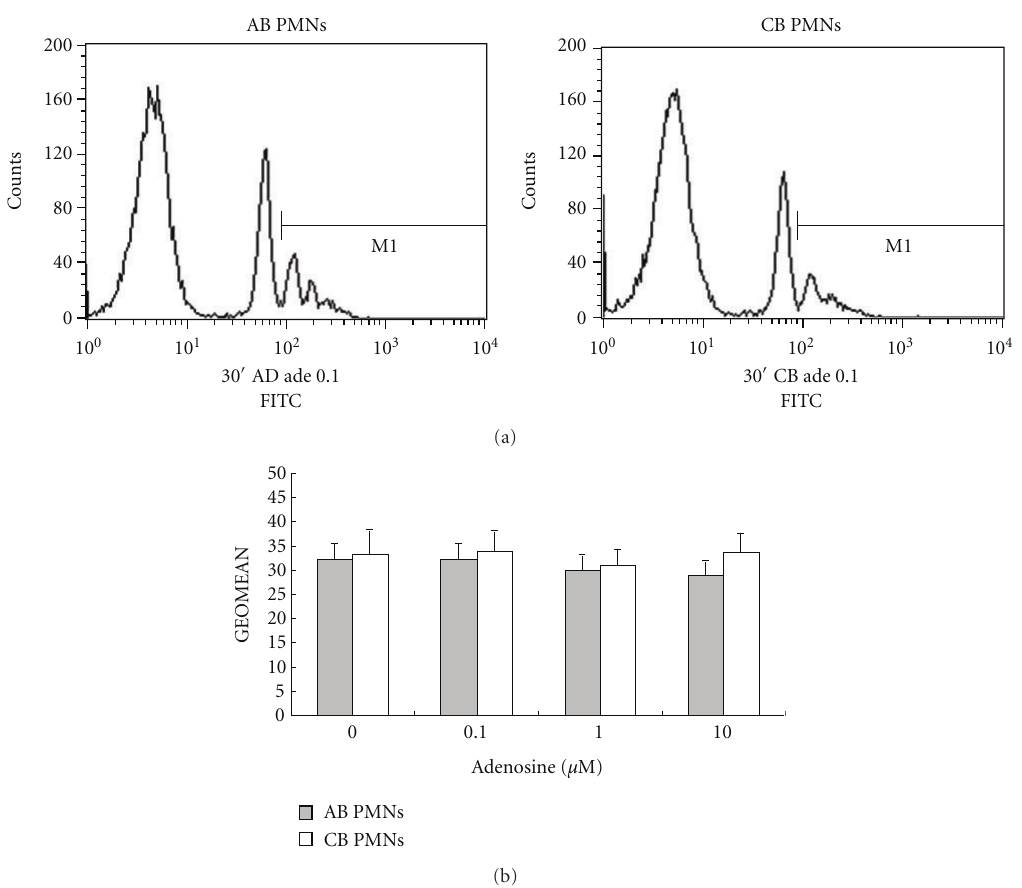
Figure 3: The modulating e ff ects of adenosine on phagocytosis of neonatal and adult PMNs. (a) The phagocytotic manifestation of cord blood PMNs was comparable with adult PMNs. The results are representative of 6 duplicate experiments. (b) Plots illustrate phagocytosis (expressed as GEOMEAN in the ordinate) of adult and cord blood PMNs. Neither adult nor cord blood PMNs phagocytosis was influenced by adenosine (Figures 3(a) and